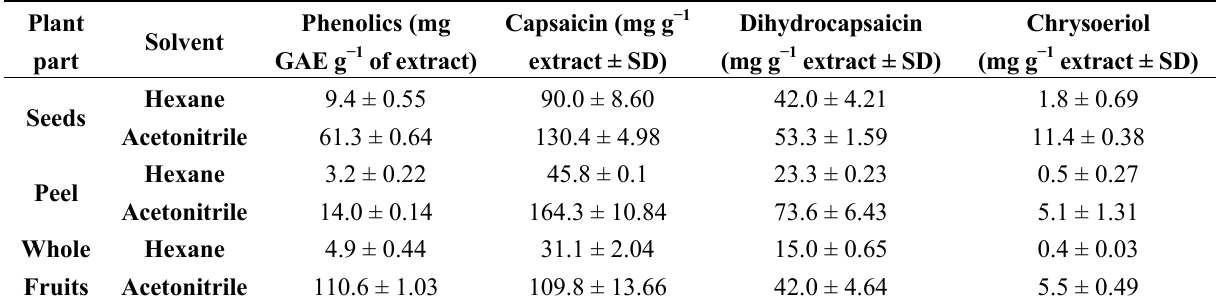
Table 1. Phytochemical content at hexane and acetonitrile extracts of seeds, peel and whole fruits of C.